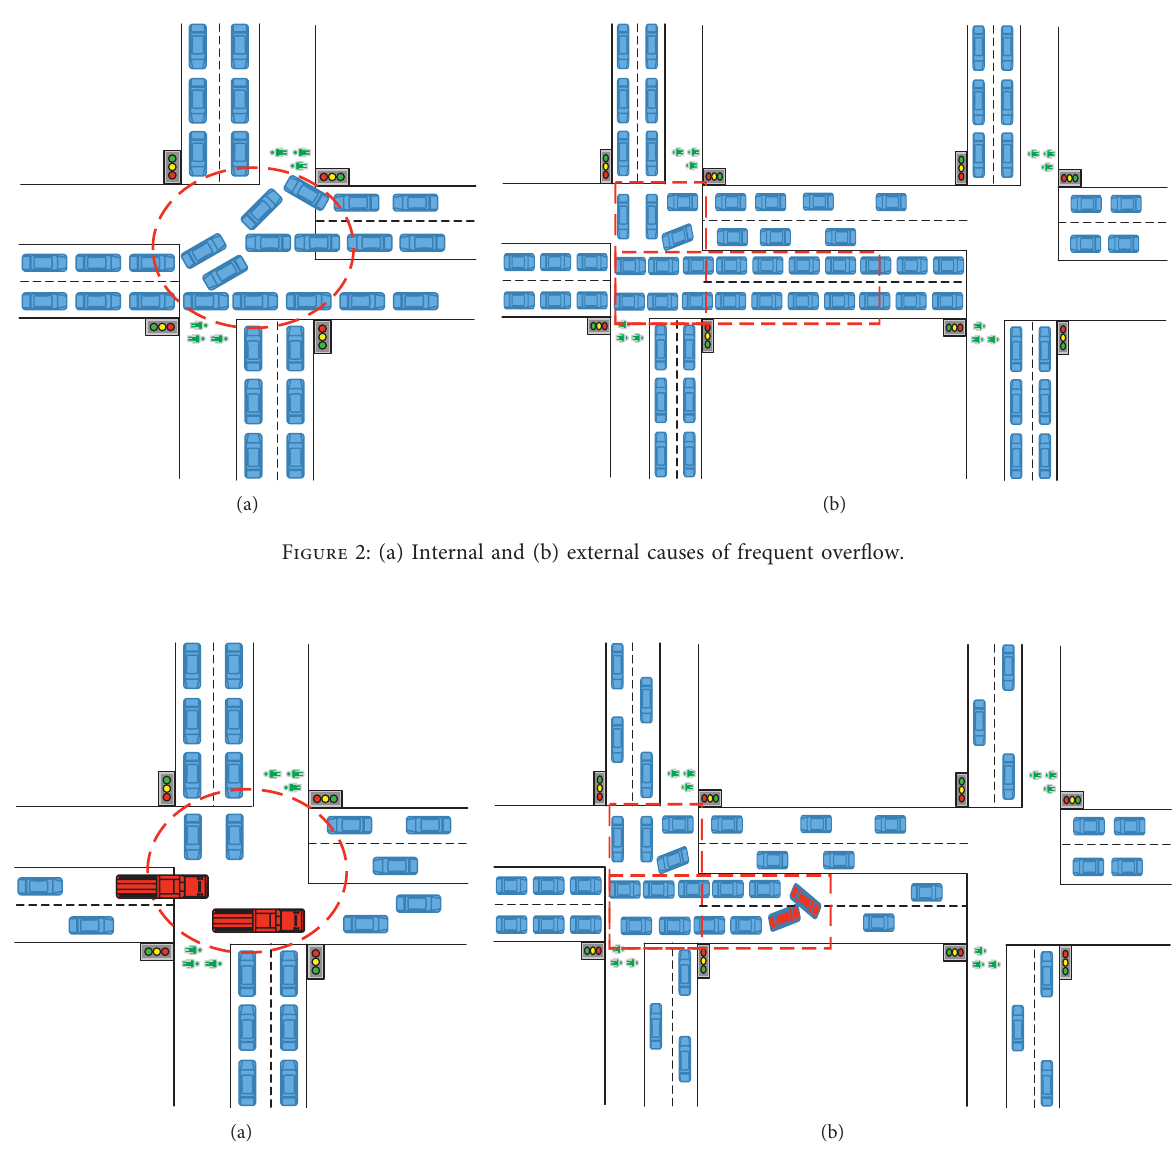
Figure 3: Causes of sporadic overflow (a) by special vehicle and (b) by traffic